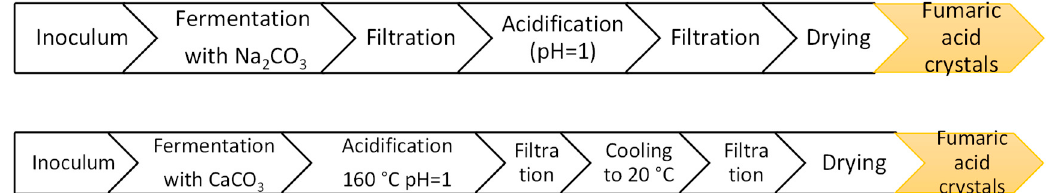
Figure 2. Operations during the fermentation process to fumaric acid depending on the basic neutralization reagent (Na 2 CO 3 or CaCO 3 ).